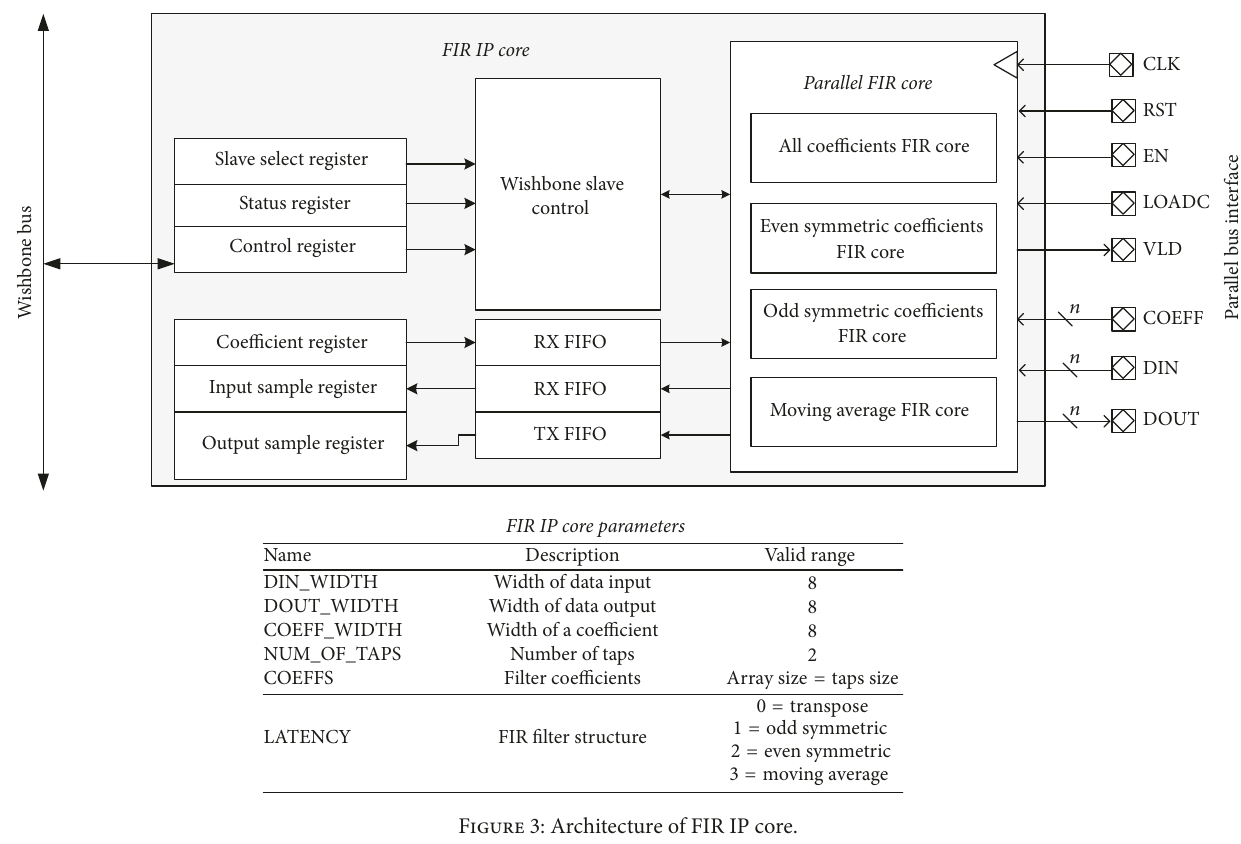
Figure 3: Architecture of FIR IP core.